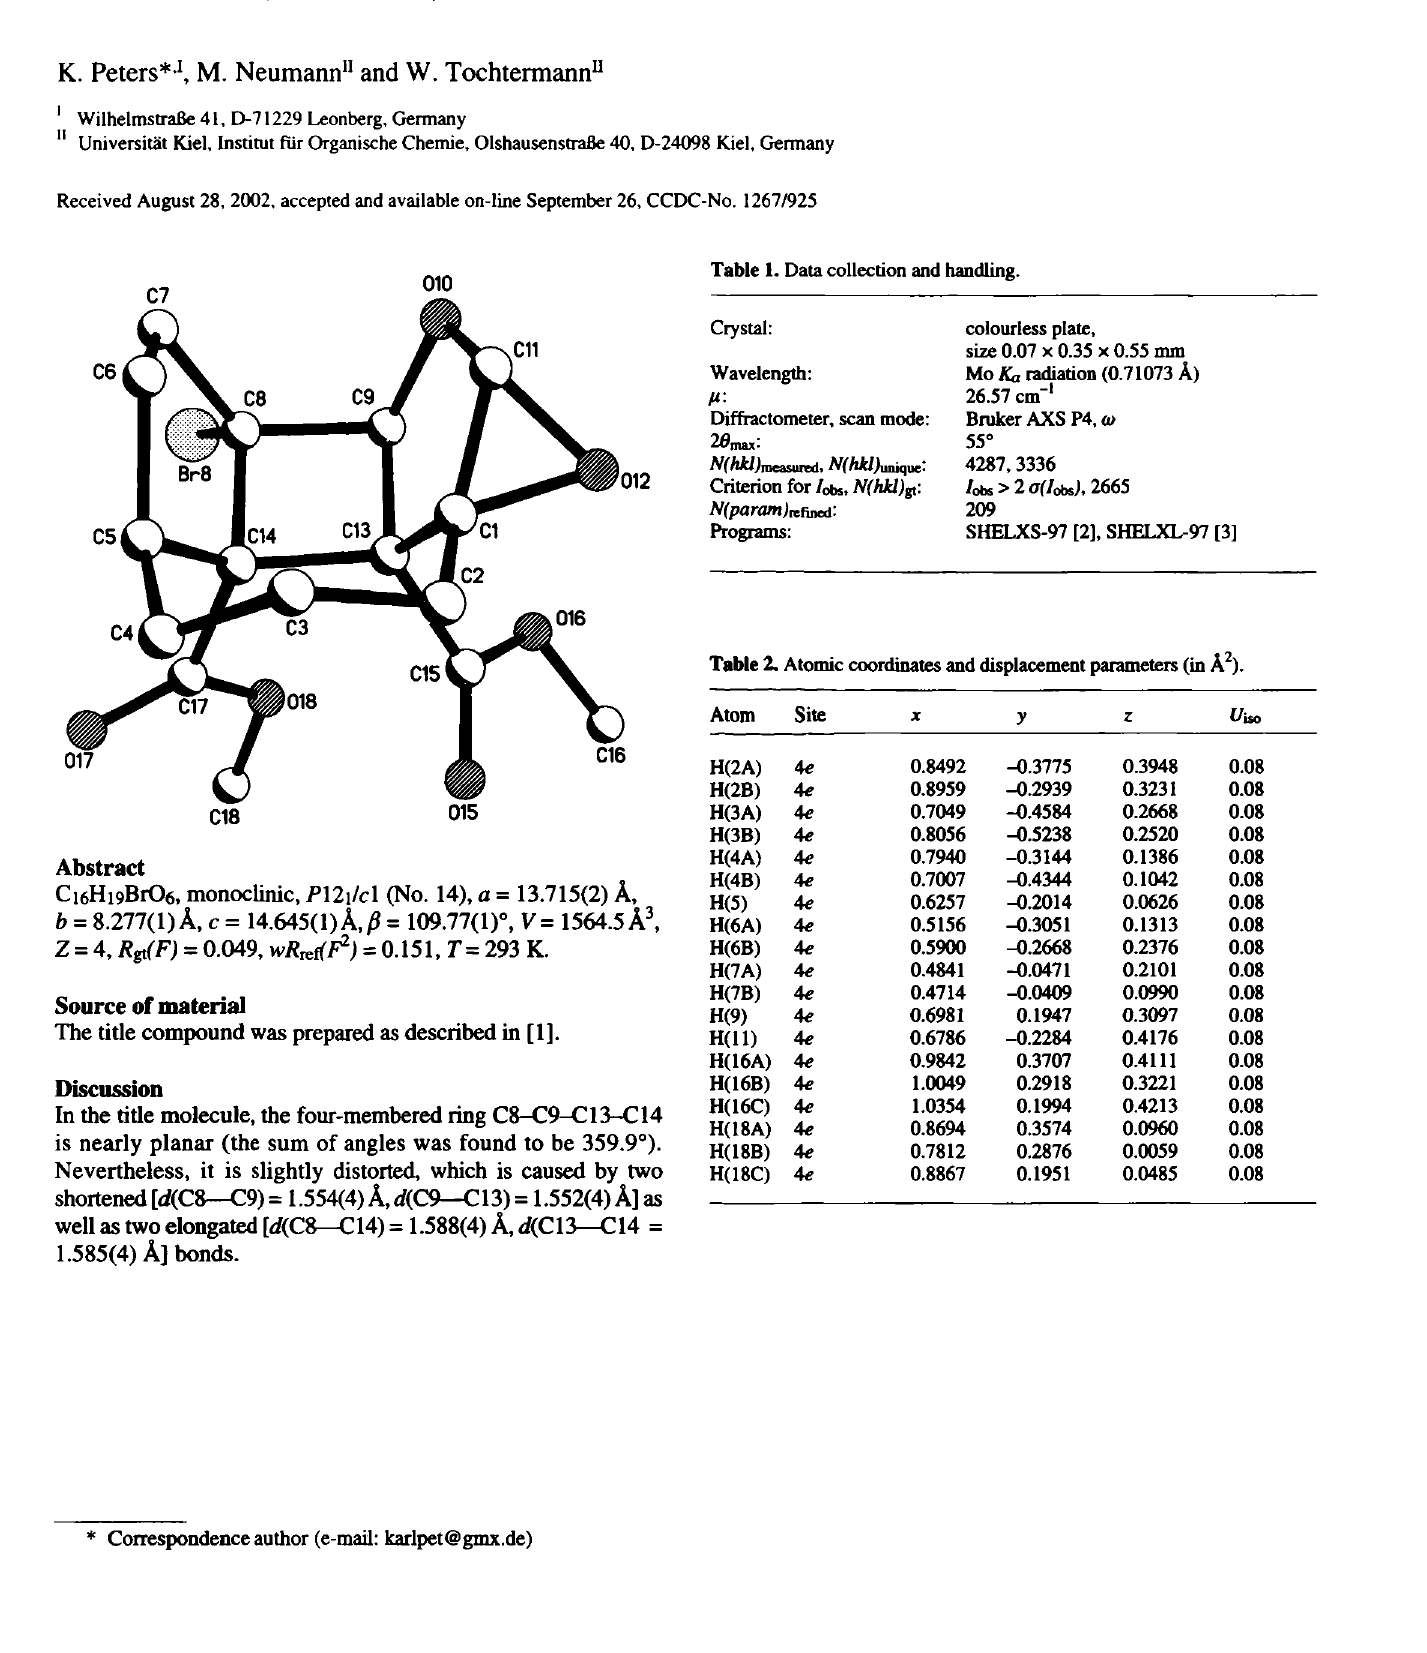
Table 2. Atomic coordinates and displacement parameters (in Â 2